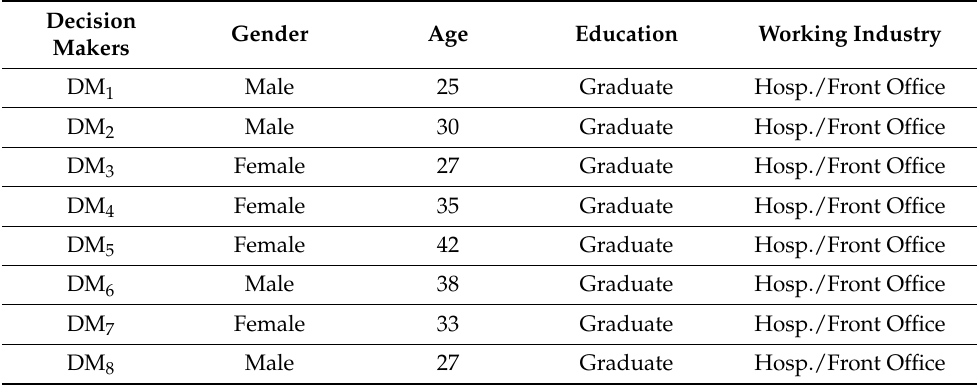
Table 3. The descriptive statistics of decision